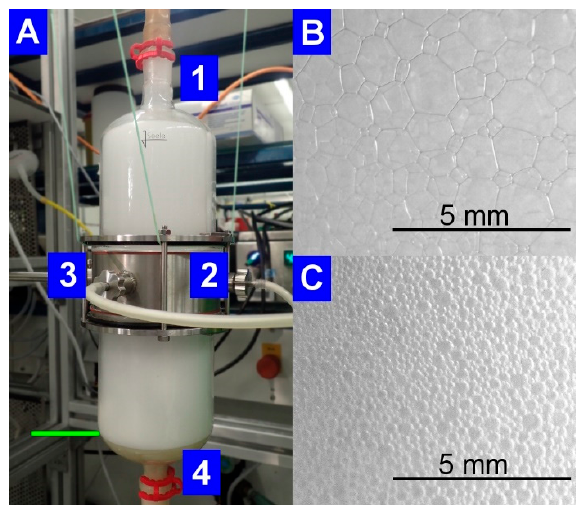
Figure 4. Pictures of the operating foam fractionation column at RL enrichment after 9.7 h of cultivation. ( A ) General view of the column with ( 1 ) the upper outlet of the fractionated foam, the connectors for ( 2 ) the inlet of the foamate from the bioreactor, and ( 3 ) the outlet for the drainage reflux and to maintain the liquid level of the pool (indicated by green line), ( 4 ) the sparger positioned at the column bottom. ( B ) Polyhedral foam structure at the upper outlet of the fractionation column. ( C ) Spherical foam formation just above the pool.